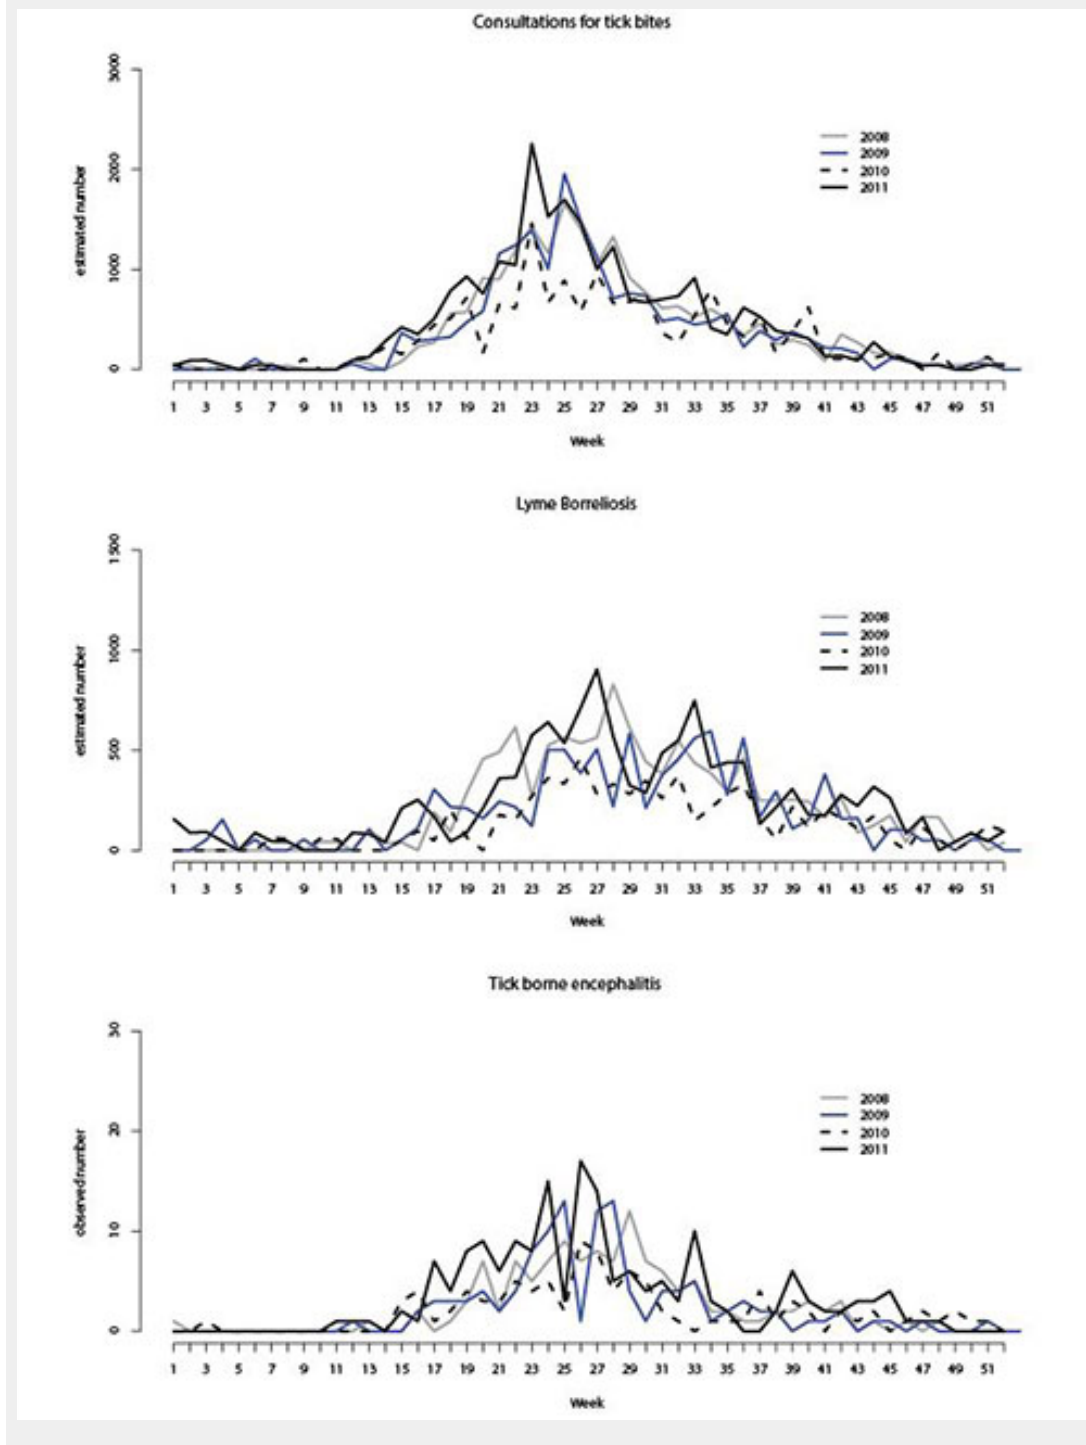
Figure 2 Seasonal time trends of treated tick bites, Lyme borreliosis (both estimated numbers of cases) and tick borne encephalitis (observed number of cases), Switzerland, 2008 to 2011. The week of the year is defined according to ISO 8601. The estimated numbers of consultations for tick bites or Lyme Borreliosis, respectively, are represented in Panel 1 and 2. Panel 3 represents the seasonal trend in tick borne encephalitis